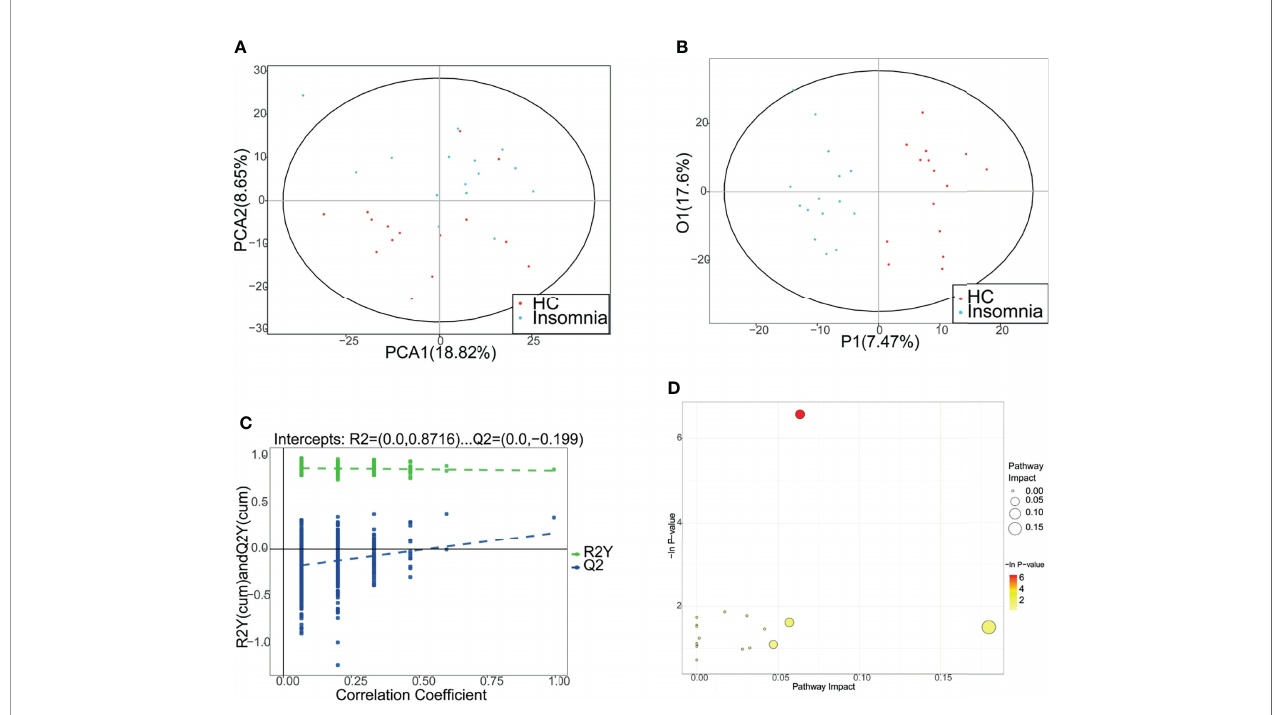
FIGURE 5 | Distinguishment between patients with insomnia and healthy controls using metabolic pro fi les. (A, B) Principal component analysis and orthogona projections to latent structures discriminant analysis (OPLS-DA) were performed to separate patients with insomnia and healthy controls using the metabolic pro fi les. Red: healthy controls. Blue: patients with insomnia. (C) The permutation test of OPLS-DA. (D) The metabolic pathway topology analysis. The horizontal axis indicates the − ln(p) values. The vertical axis indicates the impact values. PCA, principal component analysis; P1, 1st predictive principal component; O1, 1st orthogonal principal